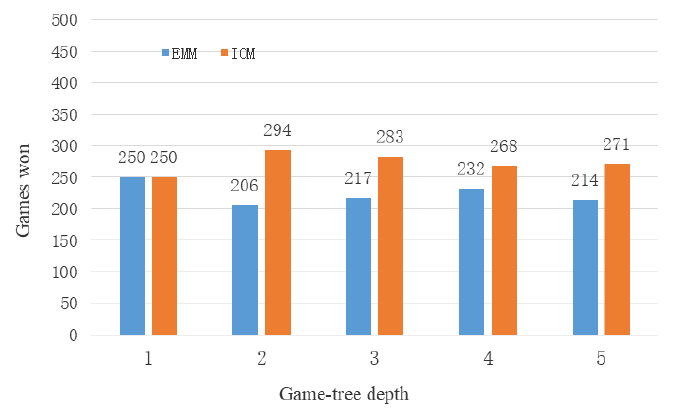
Figure 9. The experimental results for IOM vs. EMM in gobang.